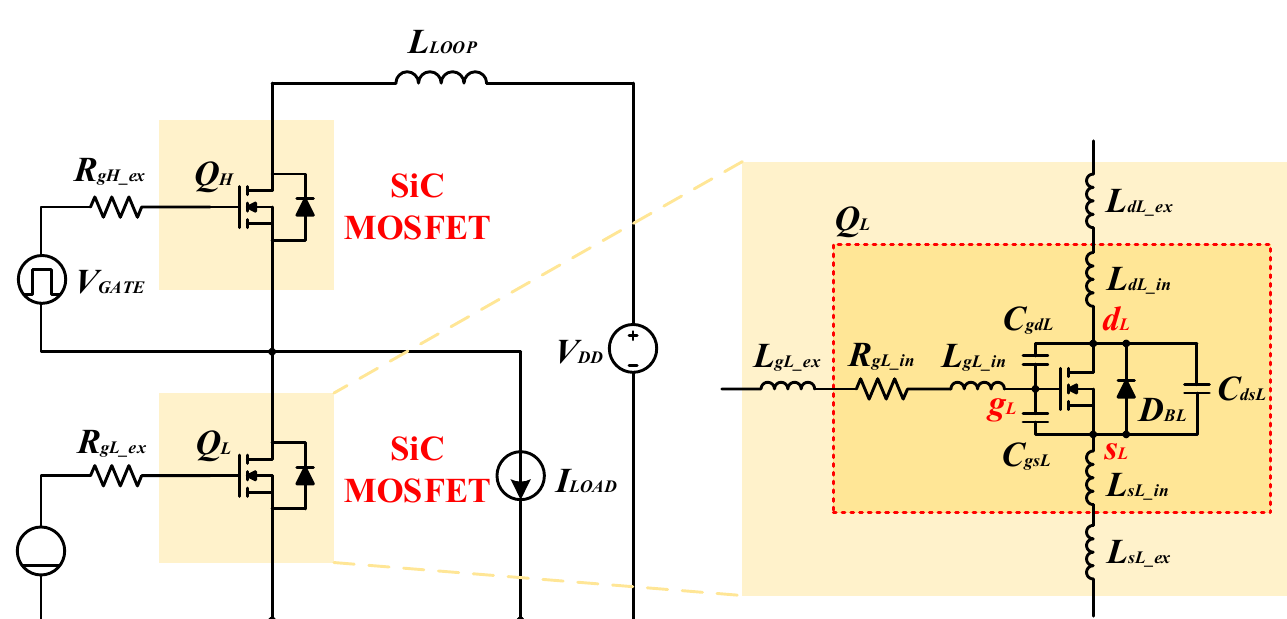
Figure 1. Equivalent model of double pulse test circuit and the parasitic elements of SiC MOSFET and bridge arm.